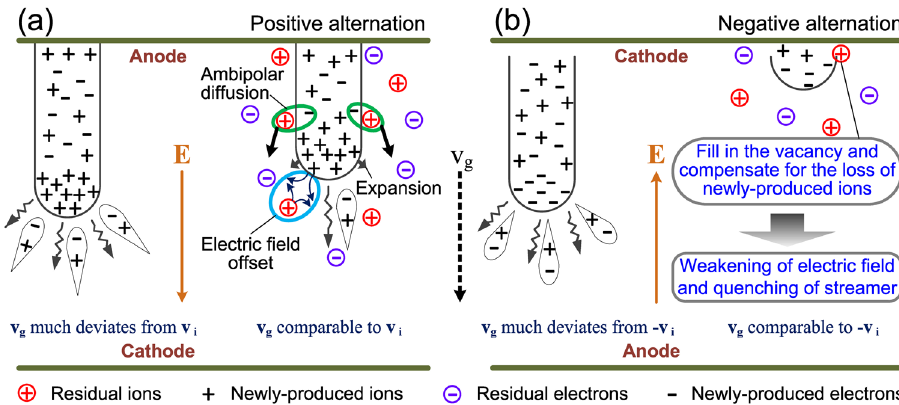
Fig. 5 Schematic diagram of the streamer evolution due to the gas fl ow. a The evolution of the positive streamer in the positive alternation. b The evolution of the negative streamer in the negative alternation. The vector v g means the gas fl ow velocity, the vector v i denotes the drift velocity of newly produced ions in the streamer channel, the vector E indicates the electric